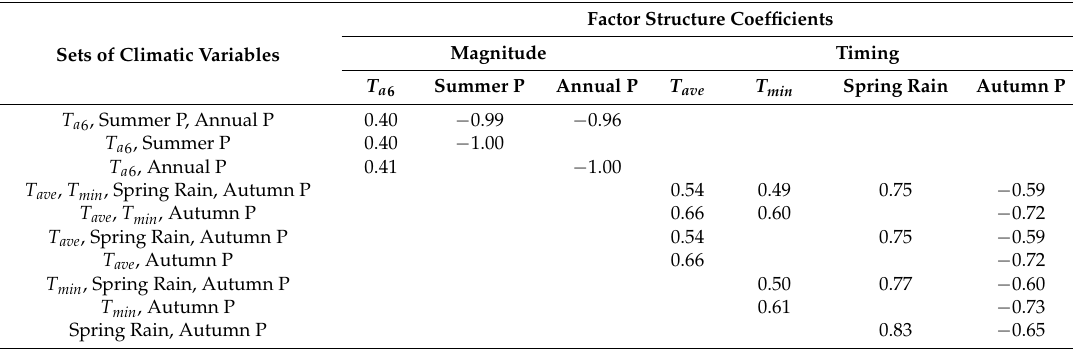
Table A2. Canonical factor structure coefficients of climate variables in the GR